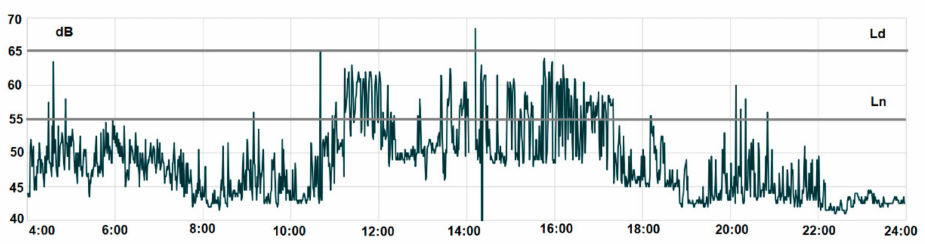
Figure 11. Example of noise recording at the site of the Arnotegi tunnels.